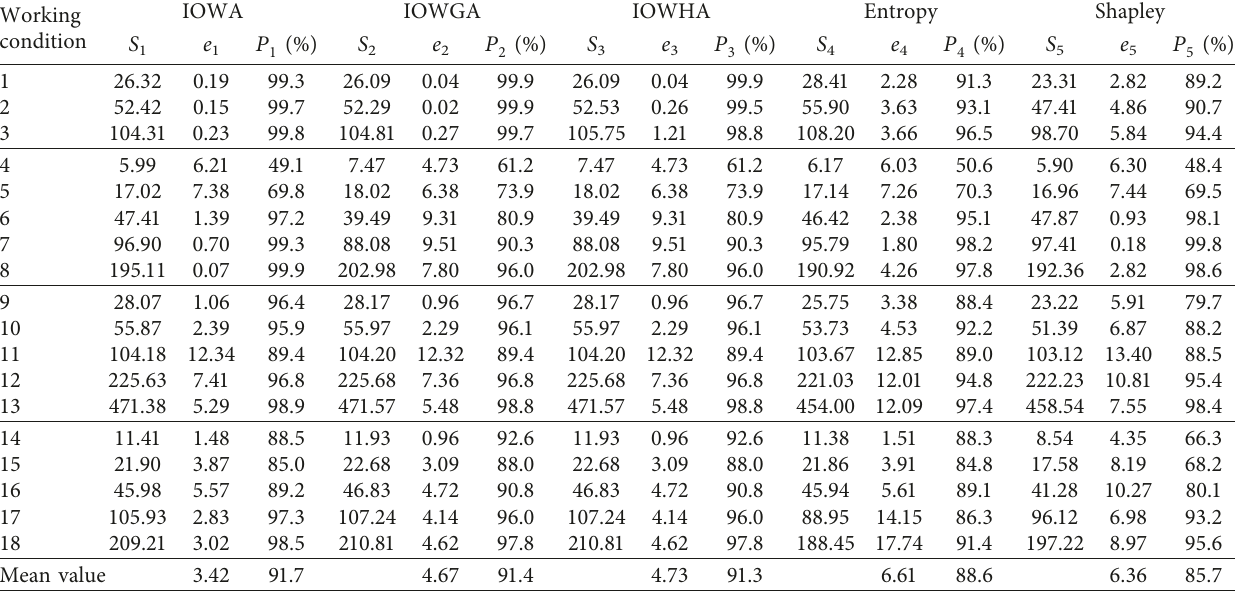
Table 3: Results of each combined forecasting model.